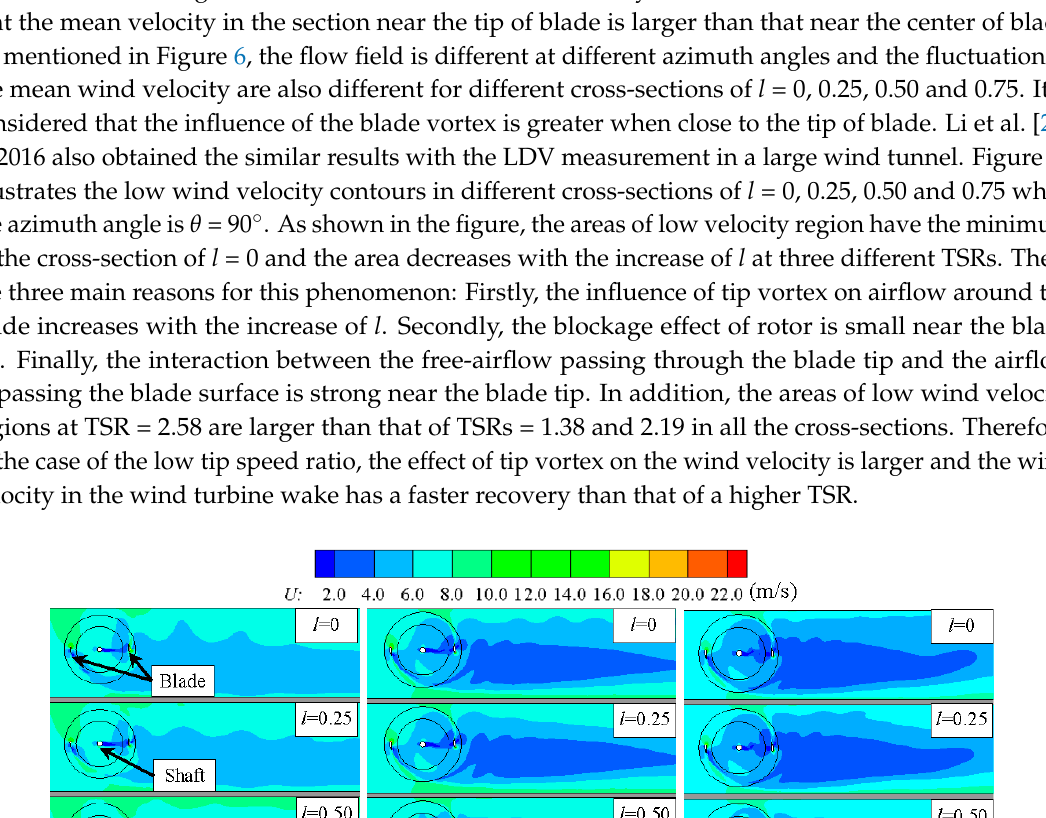
Figure 9. Fluctuation of the mean wind velocity for different cross-sections of l = 0, 0.25, 0.50 and 0.75 during rotation. The mean wind velocity magnitudes are the average value in the range of − 1.6 < y/R < 1.6 at x/R = 0 .